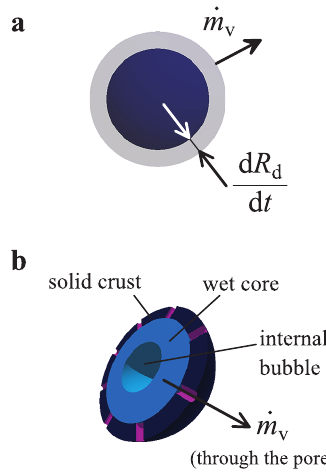
Fig. 2 Scheme of a model of hollow particle formation in spray drying process based on heat and mass balance equation: (a) first drying stage and (b) second drying